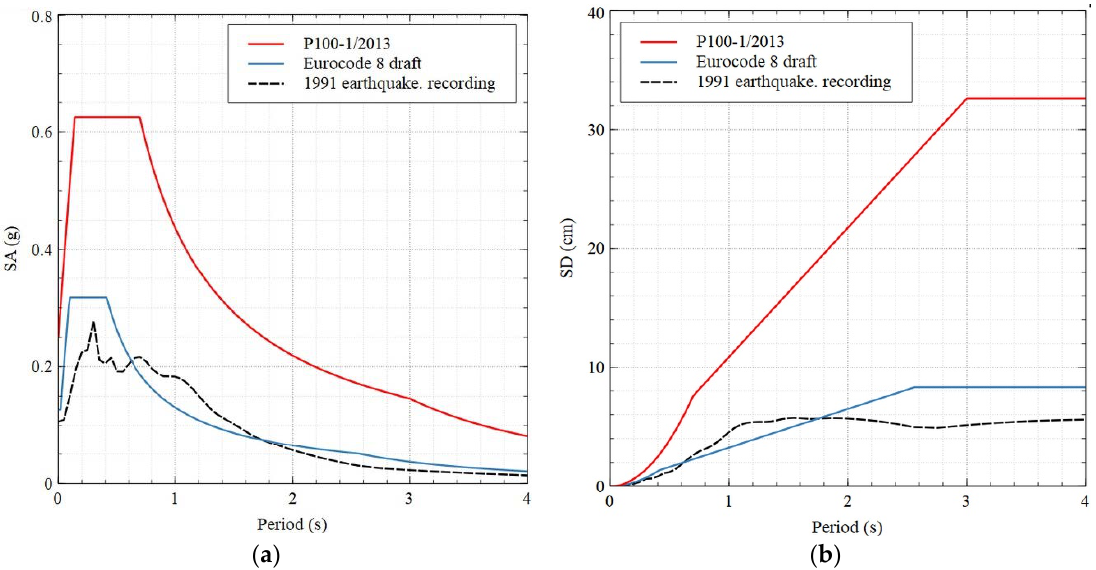
Figure 8. ( a ) A comparison between the design absolute acceleration response spectra from P100- 1/2013 [29], the Eurocode 8 draft revision [1] and the spectral accelerations of the ground motions recorded at the Banloc station during the 1991 crustal earthquake; ( b ) a comparison between the design relative displacement response spectra from P100-1/2013 [29], the Eurocode 8 draft revision [1] and the spectral displacements of the ground motions recorded at the Banloc station during the 1991 crustal earthquake.